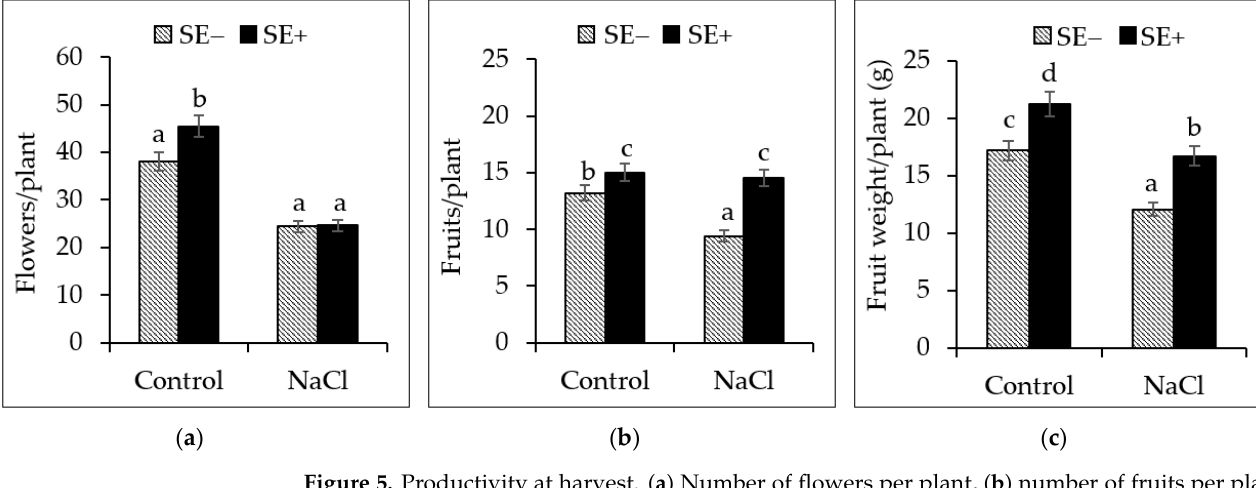
( b ) Figure 6. Proportions of tomato fruits according to size at harvest reported as percentages. Plants grown under ( a ) normal conditions (Control) and ( b ) under salinity stress conditions (300 mM NaCl) with the application of the P. gymnospora extract (0.2%; SE+) and without the extract (SE − ). Fruit size and mass categories for small (2.5–3.4 cm and 20–59 g), medium (3.5–4.4 cm and 60–83 g), and large (4.5–5.4 cm and 84–100 g) tomato fruits were used to classify fruits at harvest. 3.5. Effects of the SE on the Tolerance and Productivity of Tomato Plants as Determined by Stress Indices To better account for the observed traits, we calculated the productivity and stress- related indices (Table 6). Overall, we observed increased tolerance and productivity in tomato plants treated with the SE under salinity stress conditions compared to those of